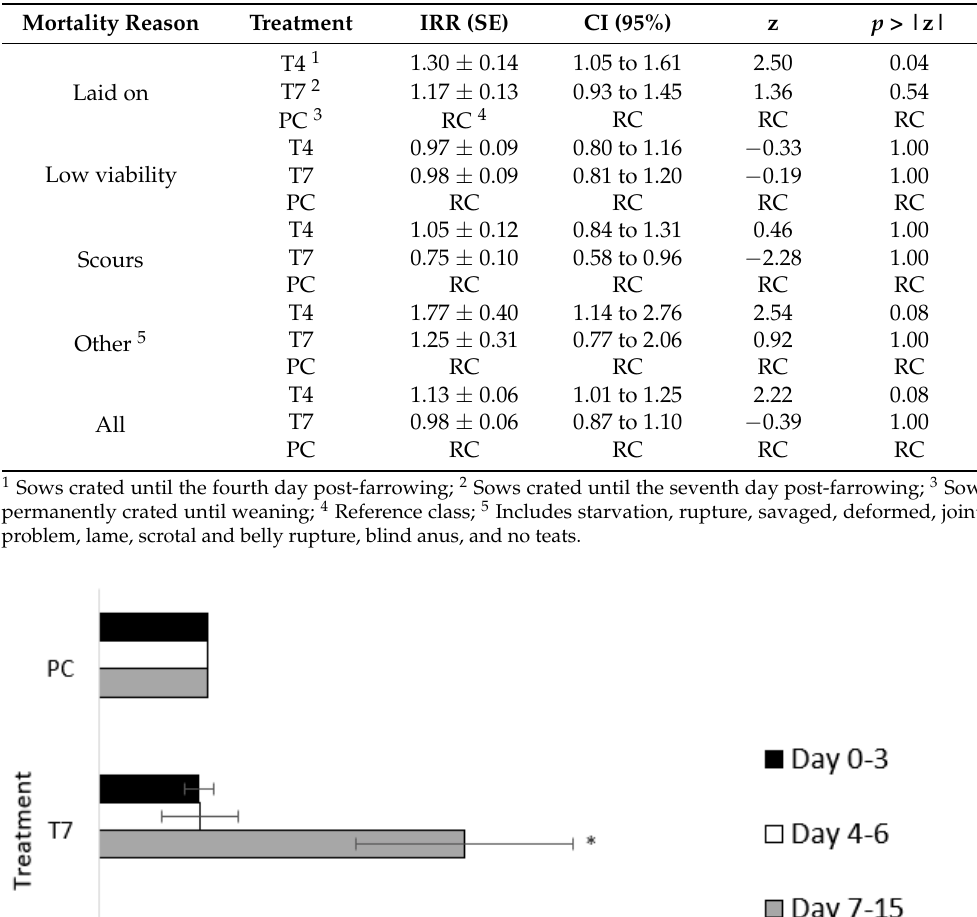
Table 2. Effect of treatment on the relative risk of piglet death for each recorded mortality reason from birth to weaning. Risk is denoted as incidence rate ratio (IRR) ± SE and 95% confidence interval (CI) for each treatment. p -values reflect the Bonferroni corrected values.